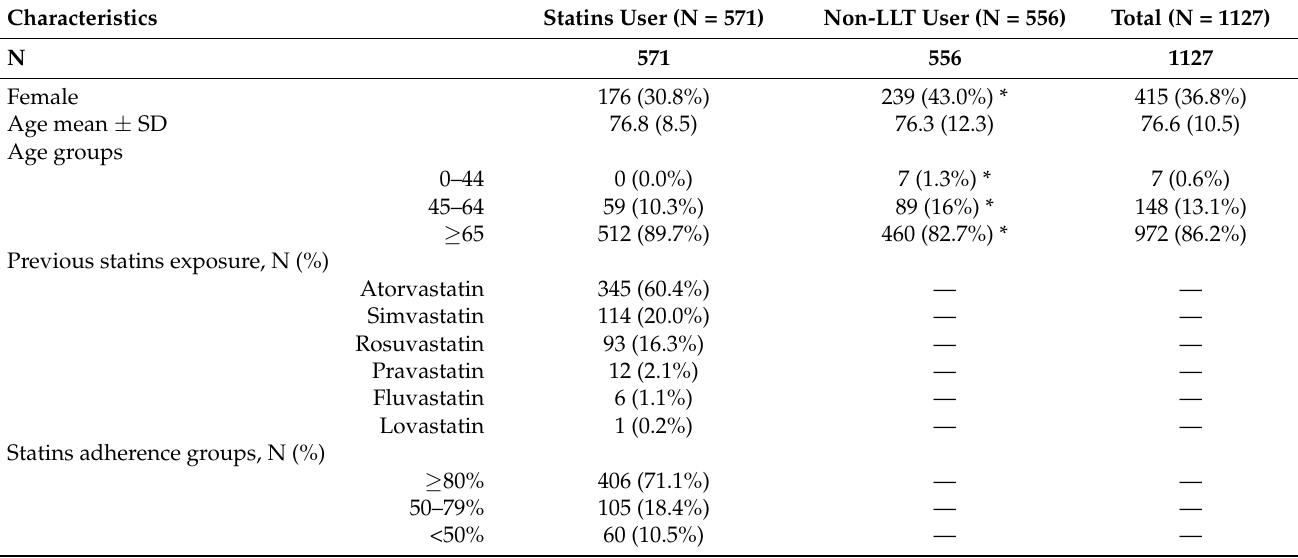
Table 1. Demographic and clinical characteristics of patients with CVDs who tested positive